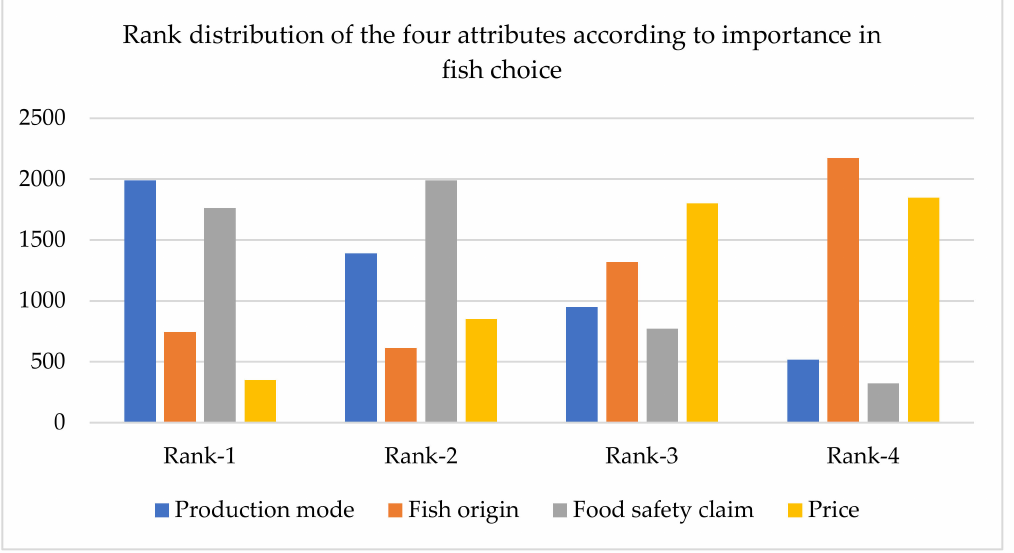
Figure 4. Consumers fish attribute choice. The vertical axes indicates the number of